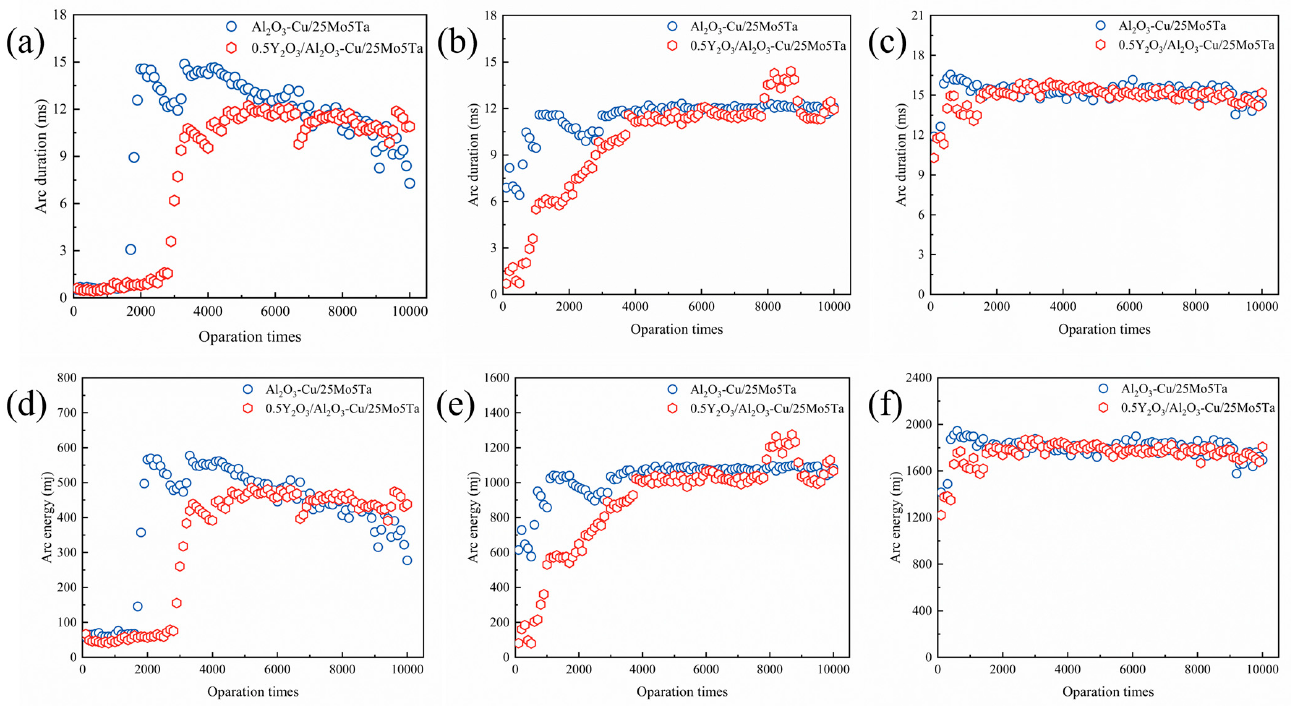
Figure 4. Variation of arc duration and arc energy with the operation times for Al 2 O 3 -Cu/25Mo5Ta and 0.5Y 2 O 3 /Al 2 O 3 -Cu/25Mo5Ta electrical contact materials: ( a ) 10 A; ( b ) 20 A; ( c ) 30 A; ( d ) 10 A; ( e ) 20 A; ( f ) 30 A.